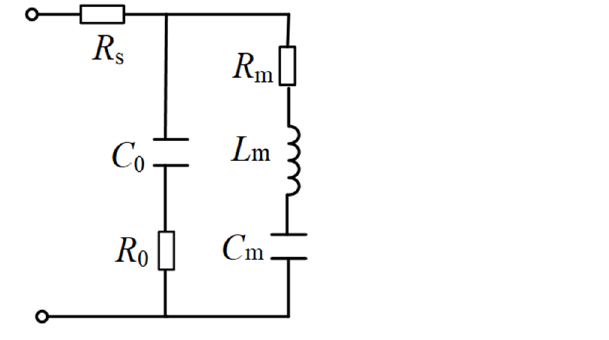
Figure 3. The modified Butterworth–Van Dyke (MBVD) circuit for the ME